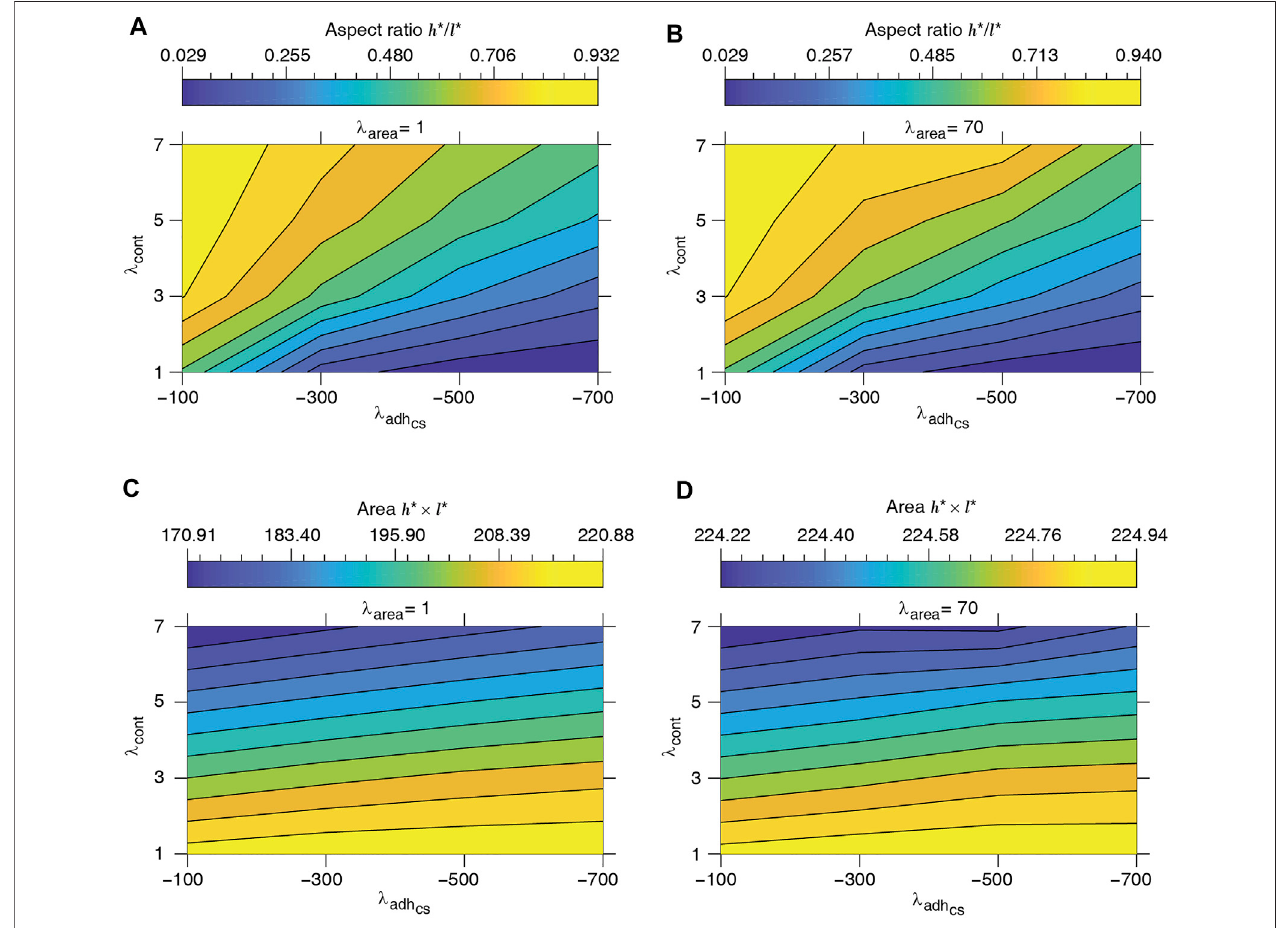
FIGURE4| Equilibriumsingle-cellaspectratio h */ l * (A,B) andarea h *× l * (C,D) versuscell-substrateadhesion λ adh height at the mechanical equilibrium, respectively, corresponding to rectangular cell shape; see Eq. 4 .